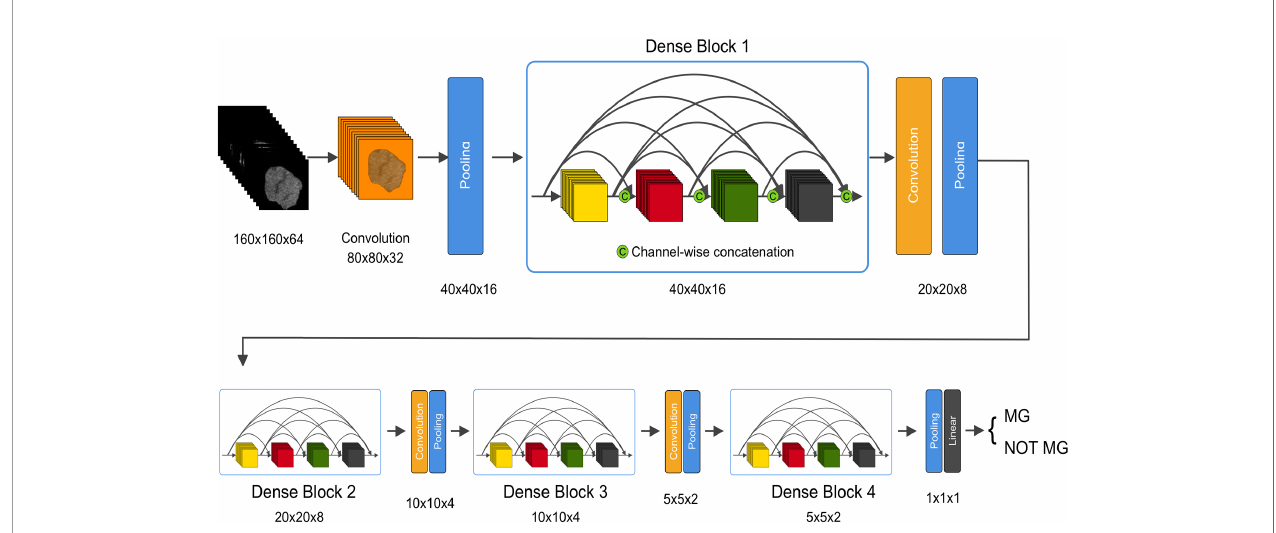
FIGURE 1 | An illustration of the architecture of our 3D DenseNet deep learning model. Images with dimension 160 × 160 × 64 pixels are fed into the network, followed by multiple convolution and pooling operations, resulting in probability prediction for MG. In dense block, features with different levels are concatenated using skip connections. The dimension is halved after each transition